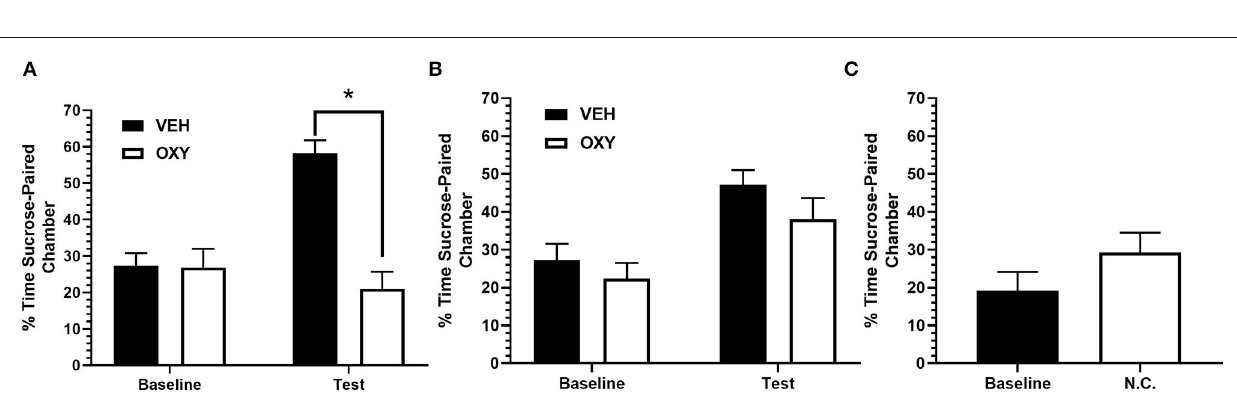
FIGURE 2 | Percentage of time spent in sucrose-paired chamber on test. (A) Rats injected with OXY displayed an attenuation in time spent in the sucrose-paired chamber during preference test relative to VEH treated rats. There was no difference in baseline preference between VEH and OXY treated rats. (B) All rats successfully acquired sucrose-associated conditioned place preference. There was no difference in time spent in sucrose-paired chamber during preference test between OXY or VEH administered during conditioning. (C) Non-conditioned rats, receiving no sucrose-pairings or drug manipulation, spent displayed no difference in time spent in sucrose-paired chamber relative to baseline. VEH = Vehicle; OXY = Oxytocin; N.C. = No conditioning * indicates significant difference at p <